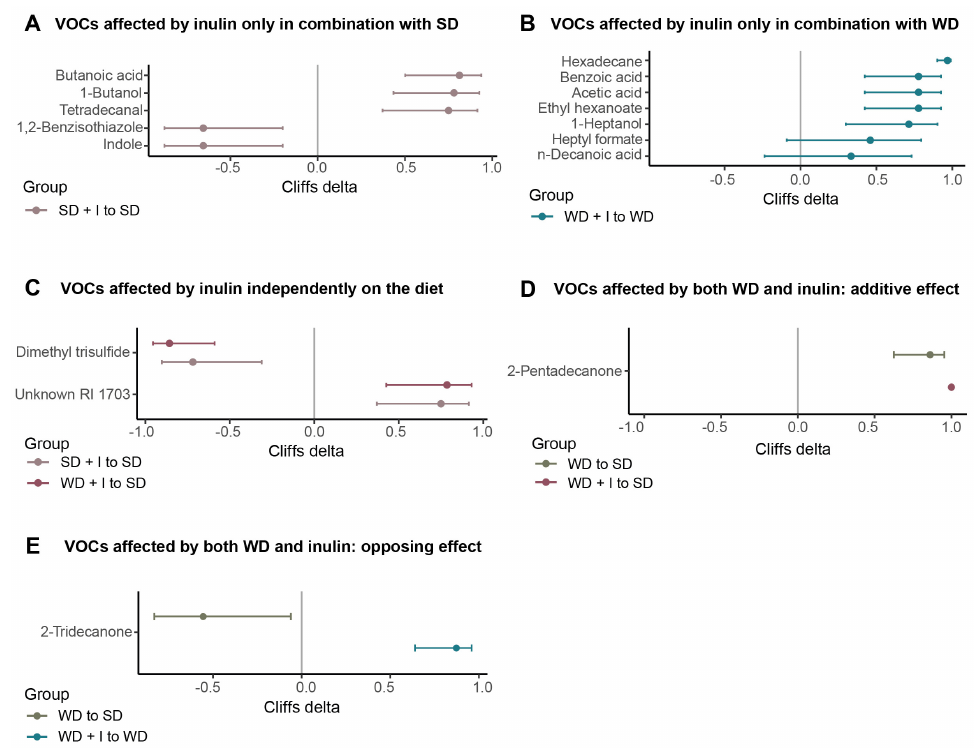
Figure 6. VOCs significantly affected by diet and/or inulin . ( A ): VOCs affected by inulin only